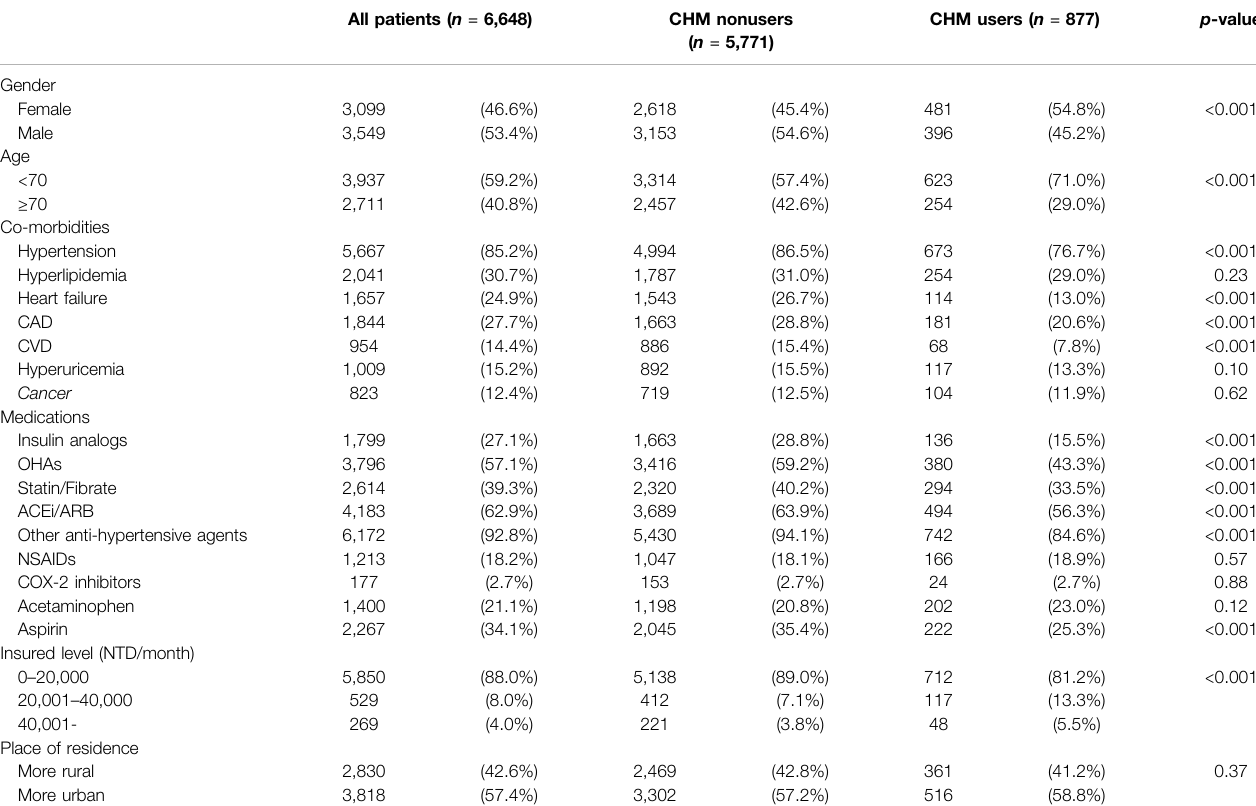
TABLE 1 | The baseline demographic features of Chinese herbal medicine (CHM) users and nonusers.